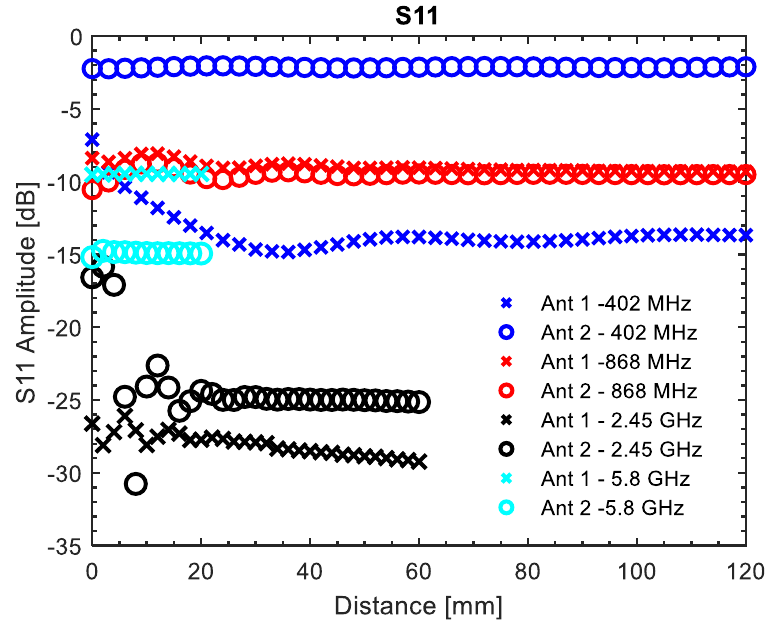
Figure 9. S 11 dB vs. distance for each antenna at different frequencies.